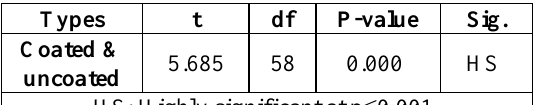
Table 6: t-test for equality of means of NBFP for CaCO 3 coated and uncoated implants